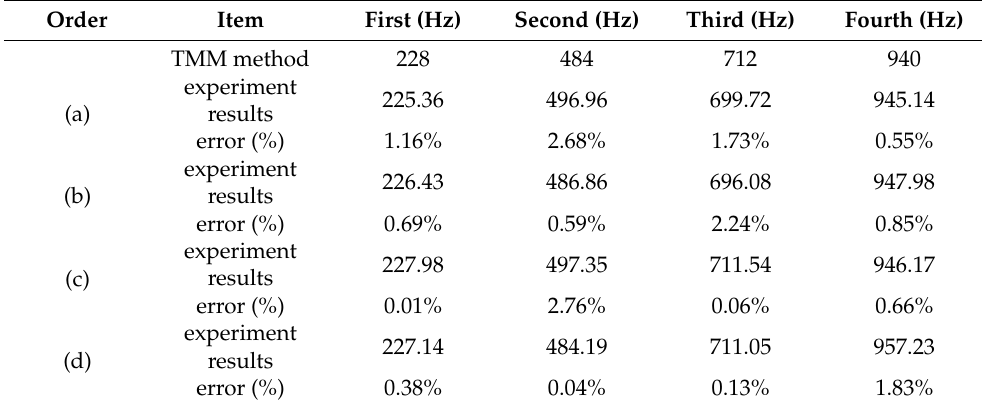
Figure 16. Velocity responses of pipe (case 4). ( a ) Axial velocity of point A. ( b ) Radial velocity of point A. ( c ) Axial velocity of point B. ( d ) Radial velocity of point B. Table 12. Resonant frequencies of pipe (case 4). Table 9. Resonant frequencies of pipe (case 1).